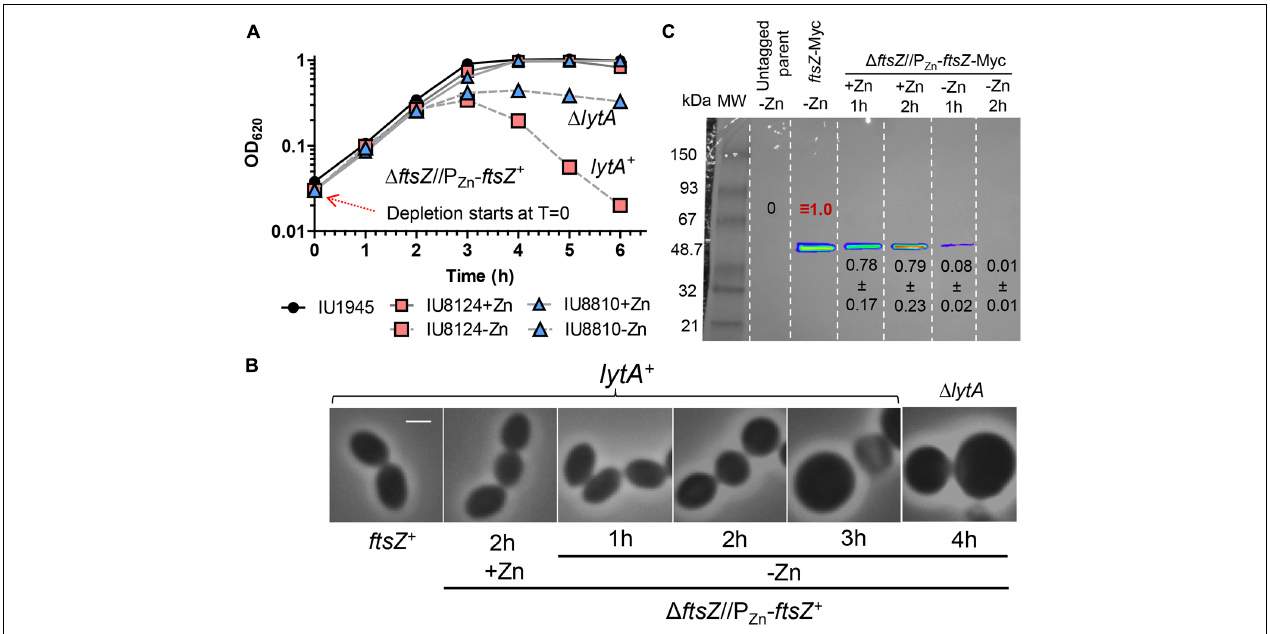
FIGURE 7 | Depletion of FtsZ results in enlarged spherical cell morphology followed by LytA induced lysis. Strains IU1945 (wild-type parent), IU8124 ( (cid:49) ftsZ //P Zn - ftsZ + ), IU8237 ( (cid:49) ftsZ //P Zn - ftsZ -Myc), and IU8810 ( (cid:49) ftsZ //P Zn - ftsZ (cid:49) lytA ) were grown exponentially in BHI broth supplemented with 0.3 mM ZnCl 2 and 0.03 mM MnSO 4 to OD 620 ≈ 0.1, spun, and resuspended in BHI broth supplemented with or without 0.3 mM ZnCl 2 and 0.03 mM MnSO 4 . (A) Representative growth curves after resuspension in BHI broth at OD 620 ≈ 0.012 containing or lacking ZnCl 2 . Red arrow indicates when depletion of ZnCl 2 started. (B) Representative images of wild-type (IU1945) or FtsZ depletion strains (IU8124; lytA + and IU8810; (cid:49) lytA ) after resuspension in BHI broth supplemented with, or lacking ZnCl 2 for 1, 2, 3, and 4 h. Resuspension OD 620 ≈ 0.36 (for T = 1 h time point) or 0.012 (for T = 2, 3 or 4 h time point). The experiment was performed at least two separate times with similar results. Scale bar = 1 µ m. See Supplementary Figure 15B for cell size measurements and statistical analysis. (C) Representative Western blot membranes containing extracts of IU1945 (untagged parent), IU7223 ( ftsZ -Myc), or IU8237 ( (cid:49) ftsZ //P Zn - ftsZ -Myc) mutant strains. Western blotting using the anti-Myc antibody is described in Materials and Methods . Protein amounts of ZnCl 2 -induced and ZnCl 2 -depleted strains relative to IU7223 ( ftsZ -Myc expressed from the native promoter) were determined and quantified as detailed in section “Materials and Methods” and are from either two or three independent biological replicate experiments ( ± SD).